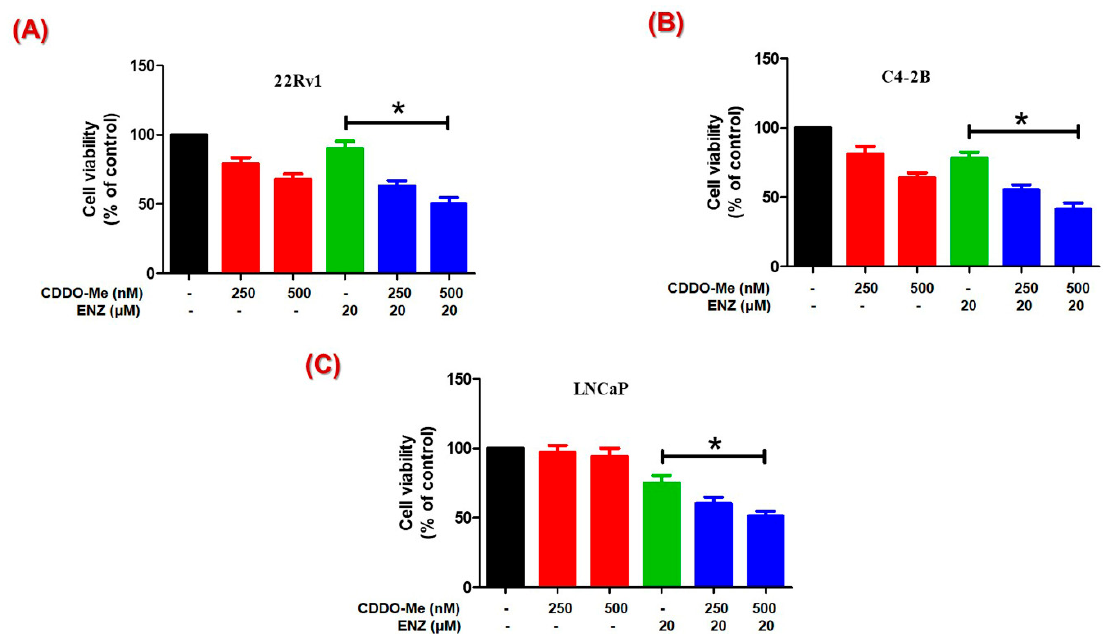
Figure 4. Effect of CDDO-Me and enzalutamide (ENZ) combination on cell viability of PC cells. Cytotoxic effect of CDDO-Me (250 and 500 nM) alone and in combination with ENZ (20 µM) at 72 h post treatment in ( A ) 22Rv1, ( B ) C4-2B, and ( C ) LNCaP cells is shown. PC cells were treated with CDDO-Me alone and in combination with ENZ and cell viability was measured at 72 h using MTT. The data (% of control) are expressed as the mean ± SEM of three independent experiments ( n = 3) and significant differences between groups are shown as p -values (* p < 0.05).